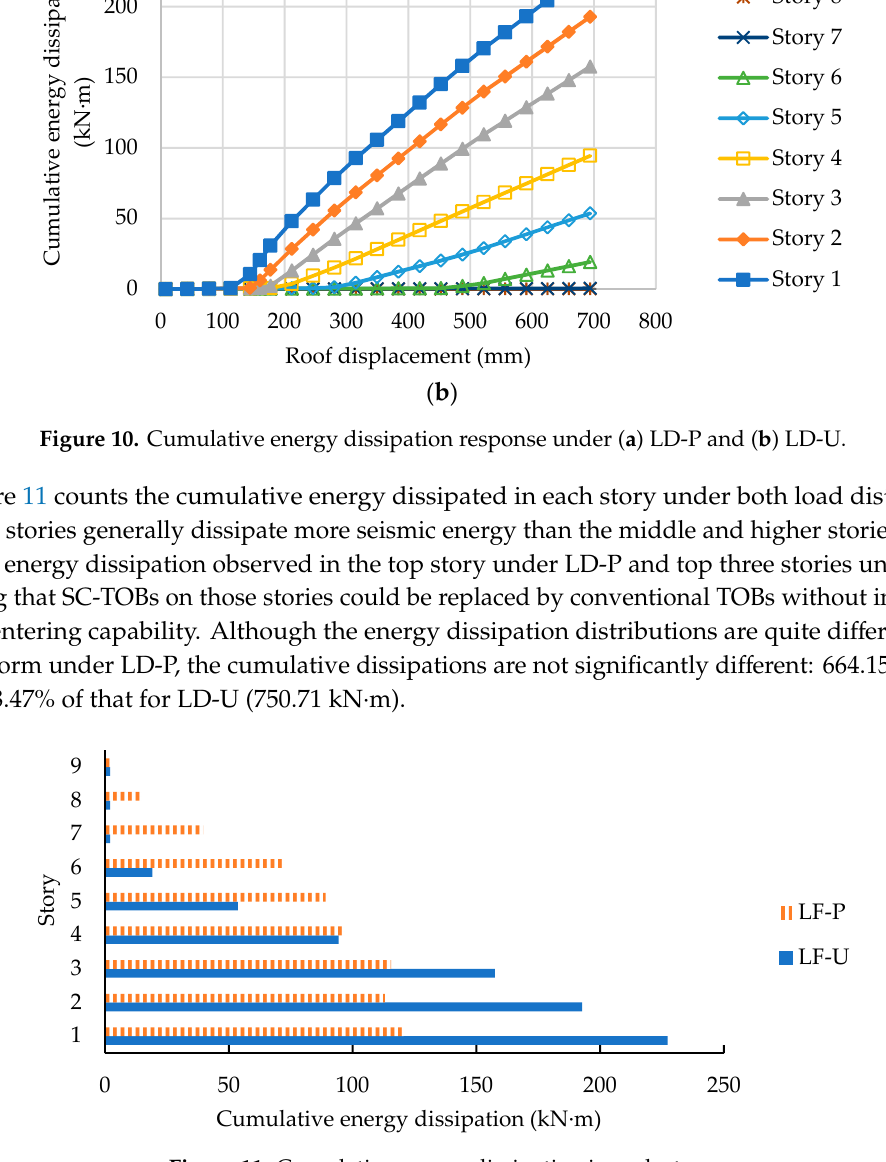
Figure 11. Cumulative energy dissipation in each story.